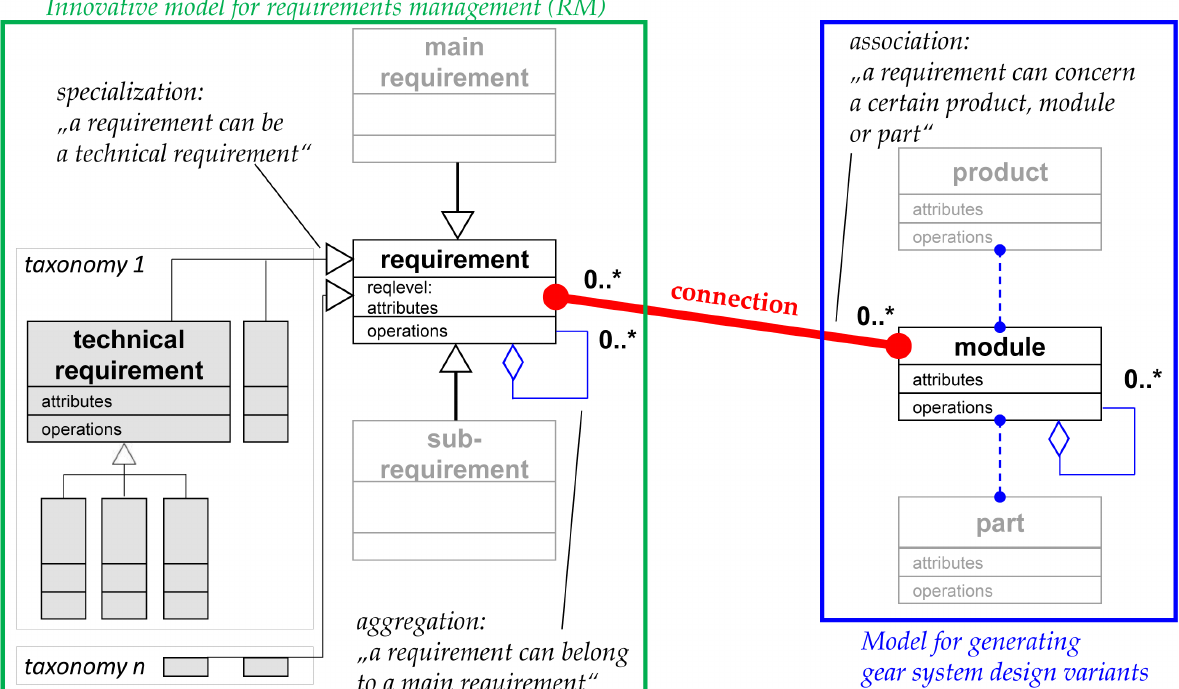
Figure 7. Product classes linked to requirement